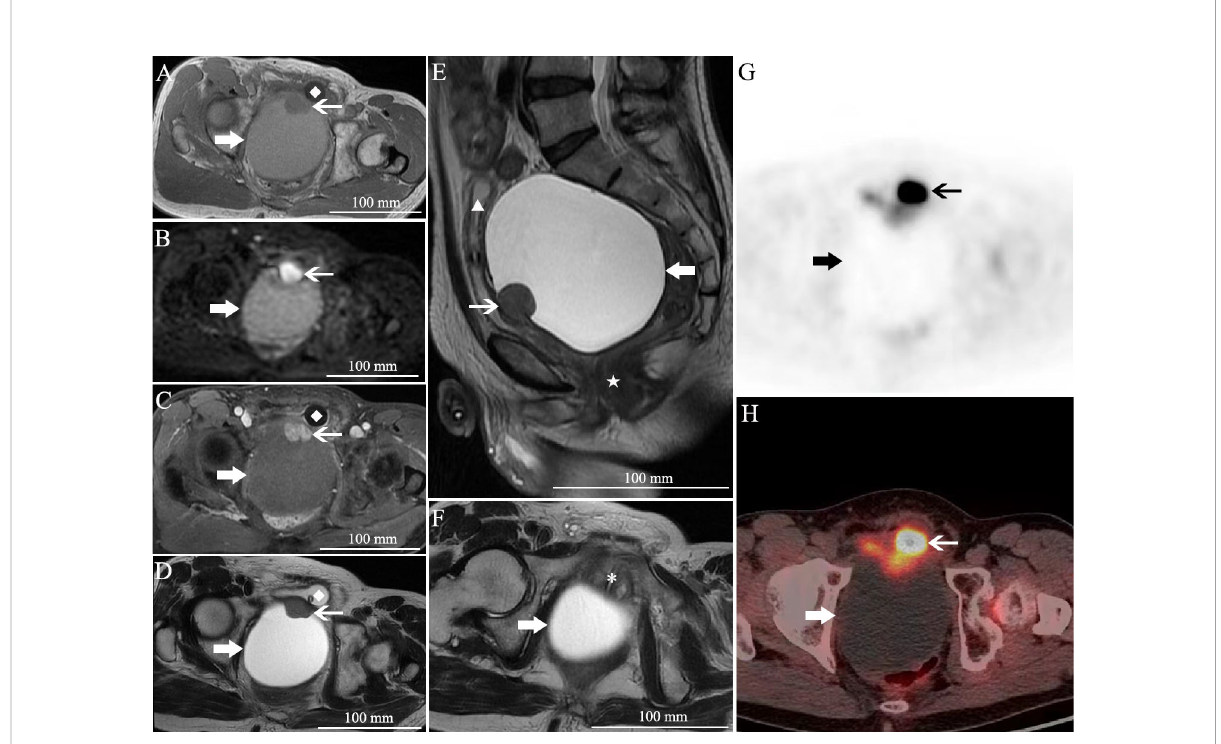
FIGURE 1 Pelvic MRI and PET/CT. (A) Axial T1 weighted image (WI), (B) axial diffusion weighted image (DWI), (C) axial gadolinium-enhanced fat-saturated T1WI, (D) axial T2WI, (E) sagittal T2WI, and (F) axial T2WI. (G, H) 18 F-FDG PET/CT. There is a giant unilocular cystic lesion measured 10.5 × 8.2 cm in size displacing the rectum ( ★ ) to the posterior, prostate (*), and bladder ( ▲ ) to the anterior. It was hyperintense on T1WI and T2WI, without diffusion restriction nor enhancement. At the anterior wall, a 2.8 × 2.1 cm solid nodule with isointensity on both T1WI and T2WI, diffusion restriction and marked enhancement, was also noted. PET/CT demonstrated an elevated SUVmax (3.5) of the solid nodule. Please note the catheter in the bladder ( ◆ ). The thick arrow, the unilocular cystic lesion; the thin arrow, the solid